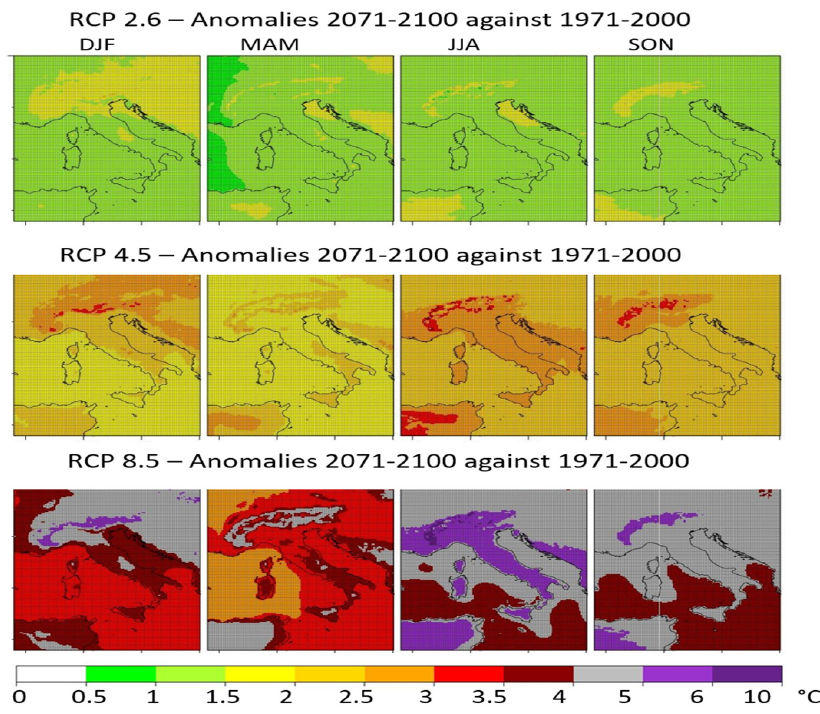
Figure 5. As Figure 3 but for anomalies expected by 2071–2100 against 1971–2000.